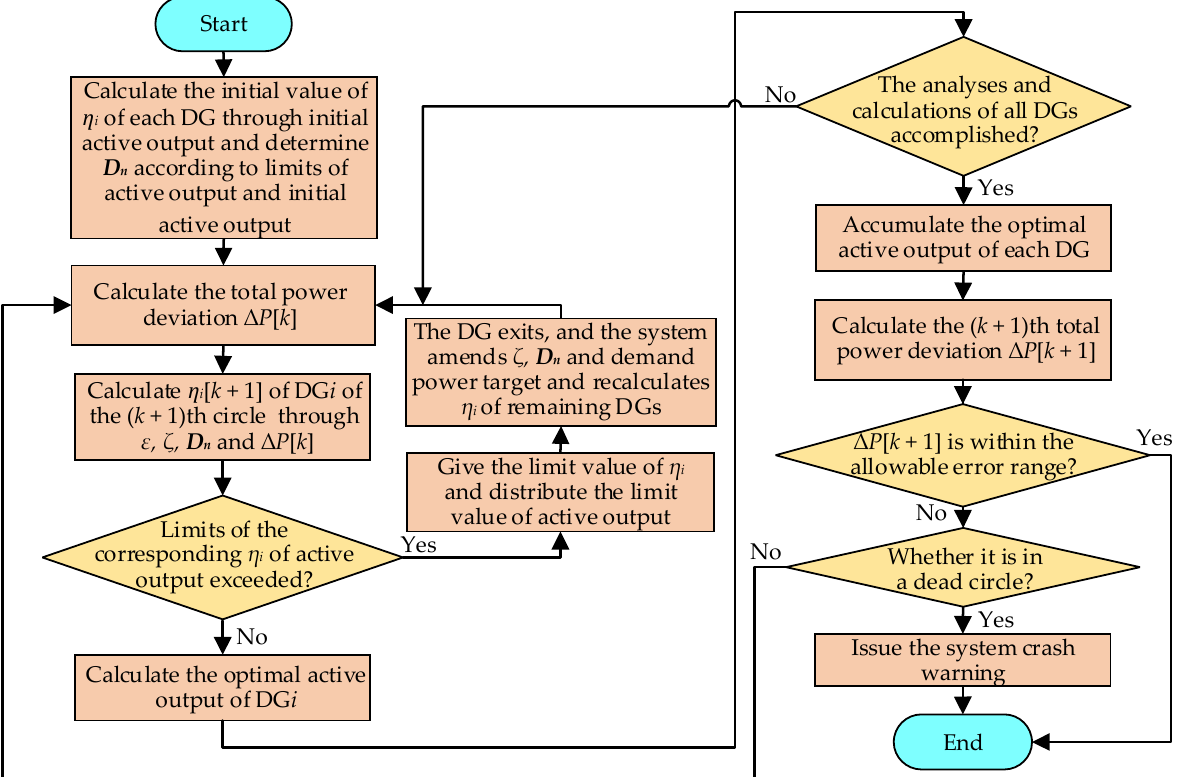
Figure 1. The flow of the improved pinning consensus algorithm based on ICR.